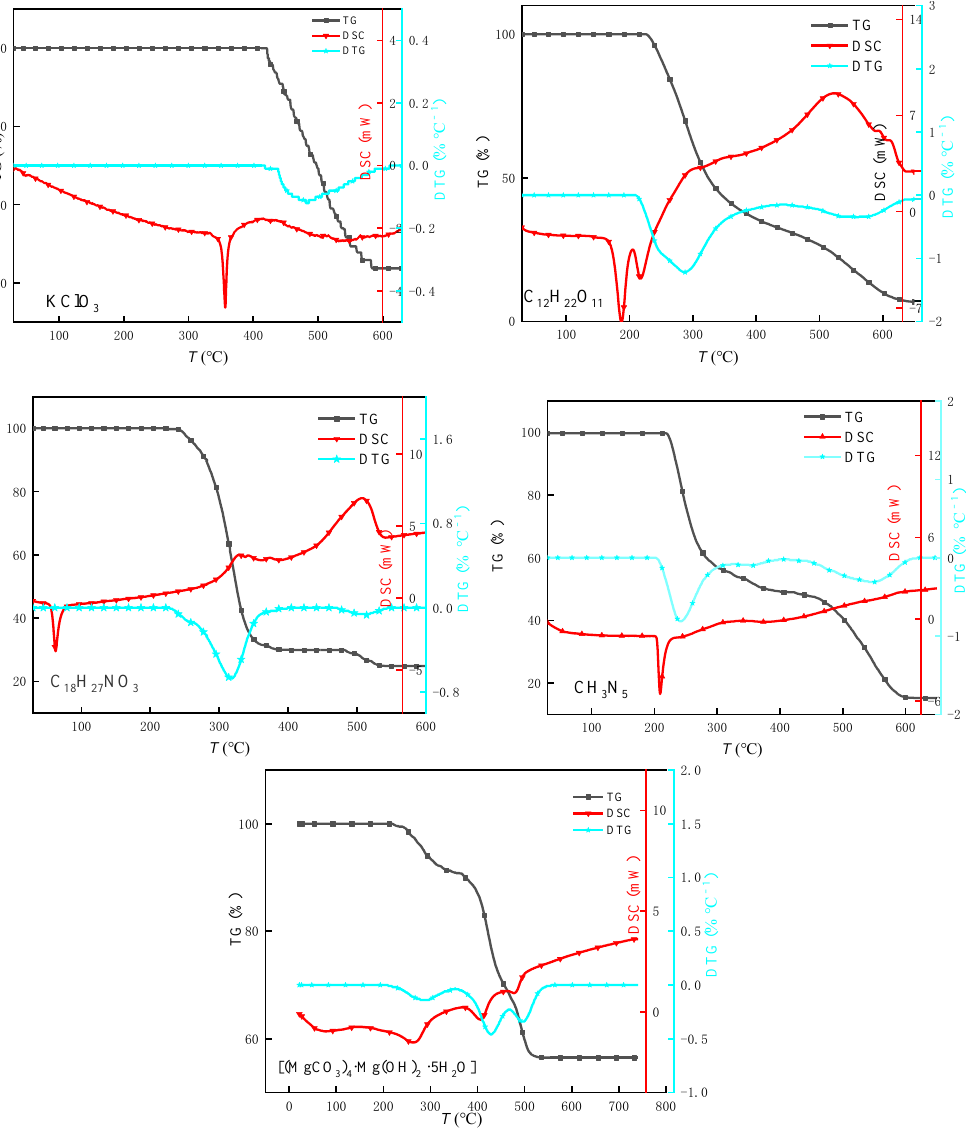
Figure 8. TG-DSC-DTG curve of each individual component in mixed reagent sample at β = 10 ◦ C · min − 1